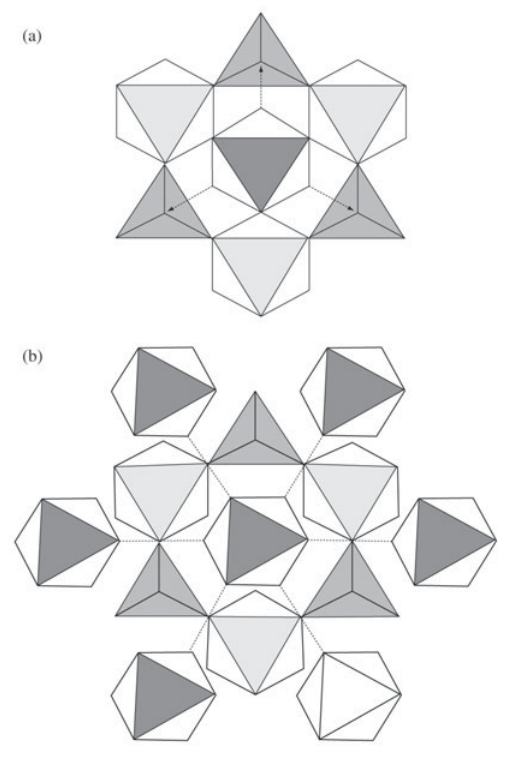
Figure 7. Polyhedral representation of alpha-zirconium phosphate intercalated with chromium (III). The monomers may be linked by hydrogen bonds to the six phosphate groups (a) or within them- selves (b) (see